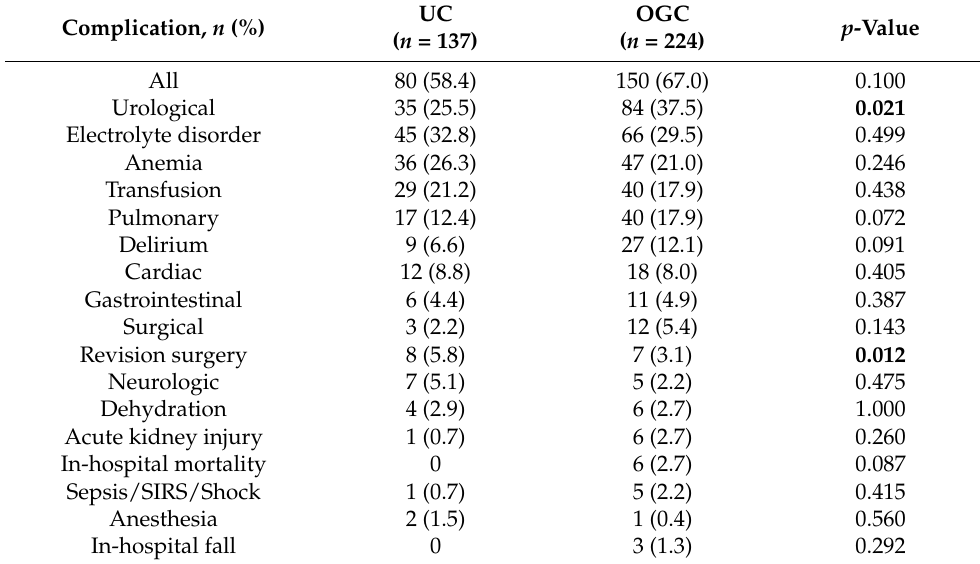
Table 3. Primary outcome